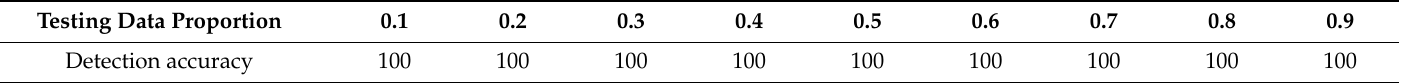
Table 7. Detection accuracy of